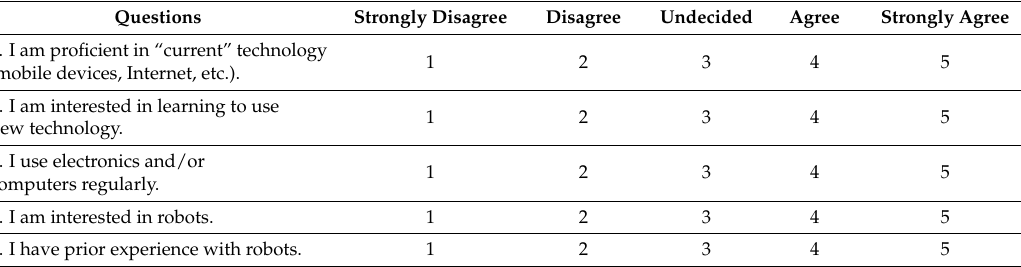
Table A4. Interim-survey section 1/3.